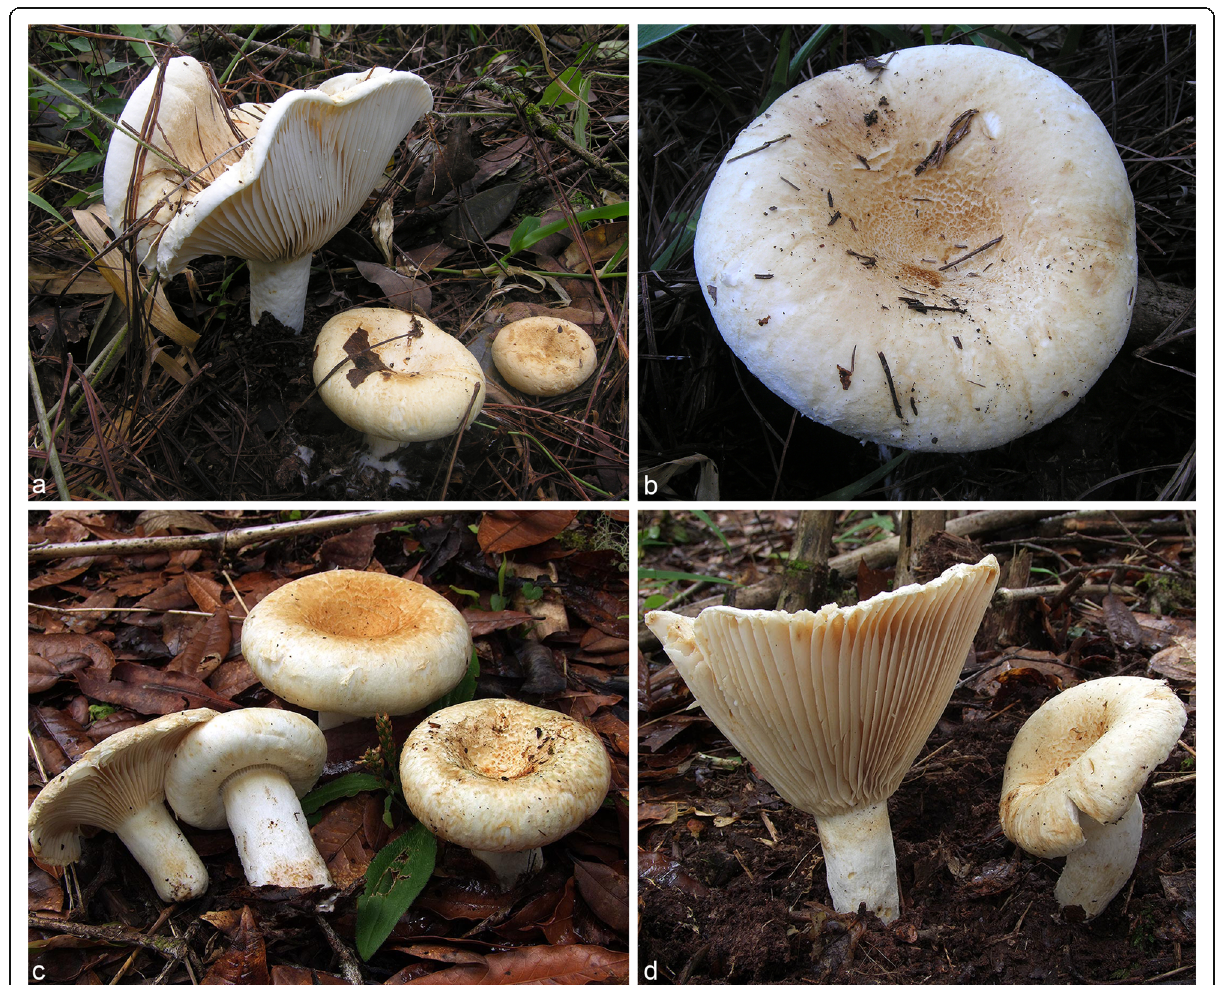
Fig. 2 Basidiomes. a Lactifluus domingensis (ANGE838 – holotype). b Lactifluus domingensis (ANGE837). c – d Lactifluus hallingii (FH 18 – 077 –